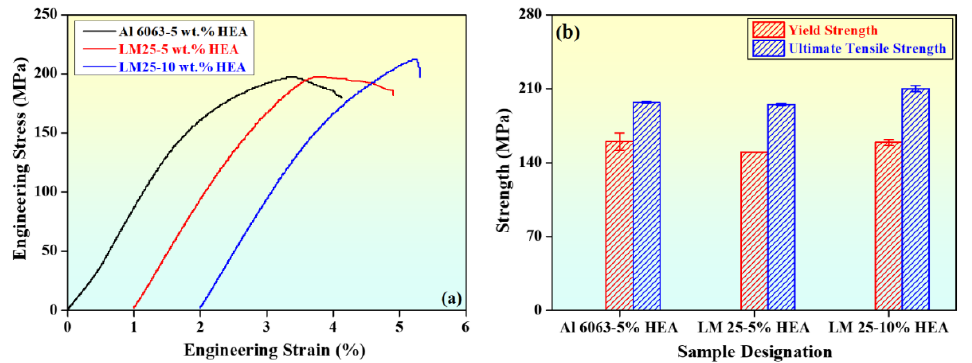
Figure 10. Mechanical properties of the Al-based metal matrix composites with different HEA content. ( a ) Stress vs. strain curve. ( b ) Variation of properties with sample designation. Table 2. Microhardness and tensile properties of Al-based metal matrix composites with different concentrations of HEA